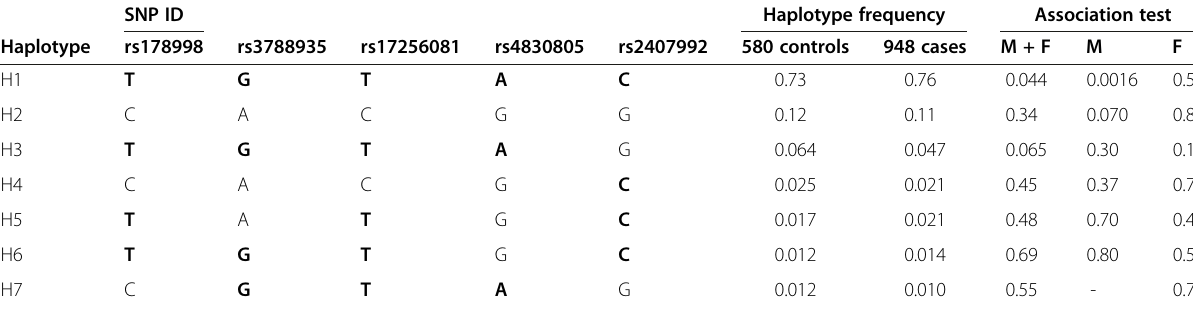
Table 4 Association of haplotypes in TLR8 with AR in the Chinese population SNP